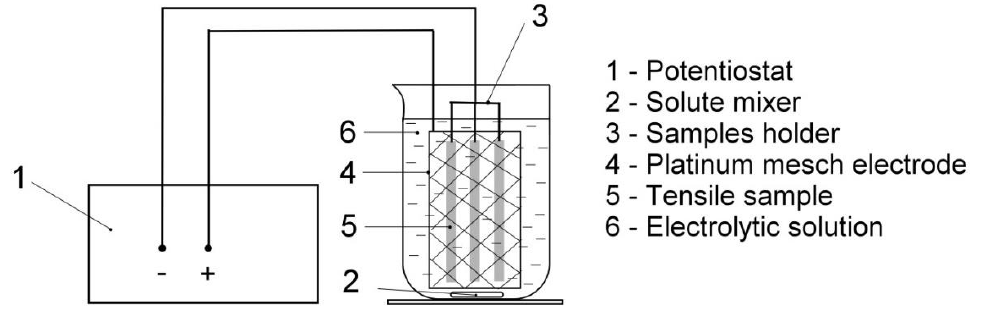
Figure 3. Schematic illustration of electrolytic hydrogenation.